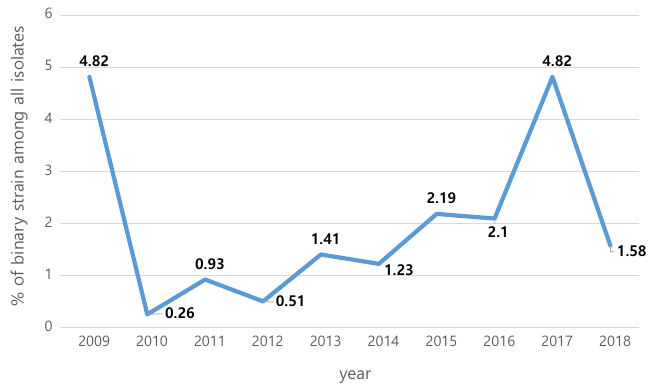
Figure 1. Annual percentage of binary toxin-positive Clostridioides difficile among all the isolates by year.